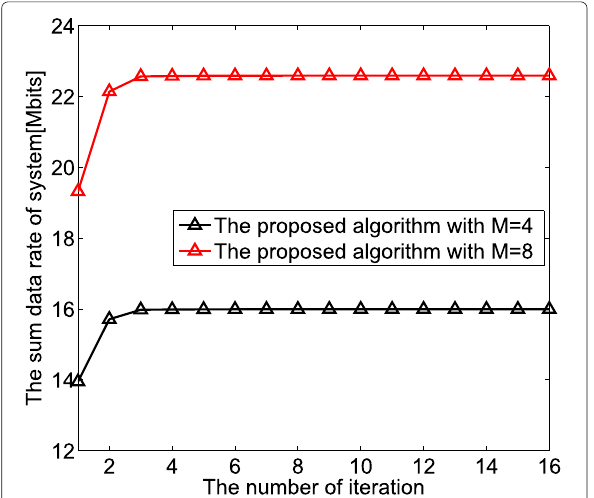
Fig. 3 Convergence of the proposed Algorithm 1 under different number of transmit antennas at the